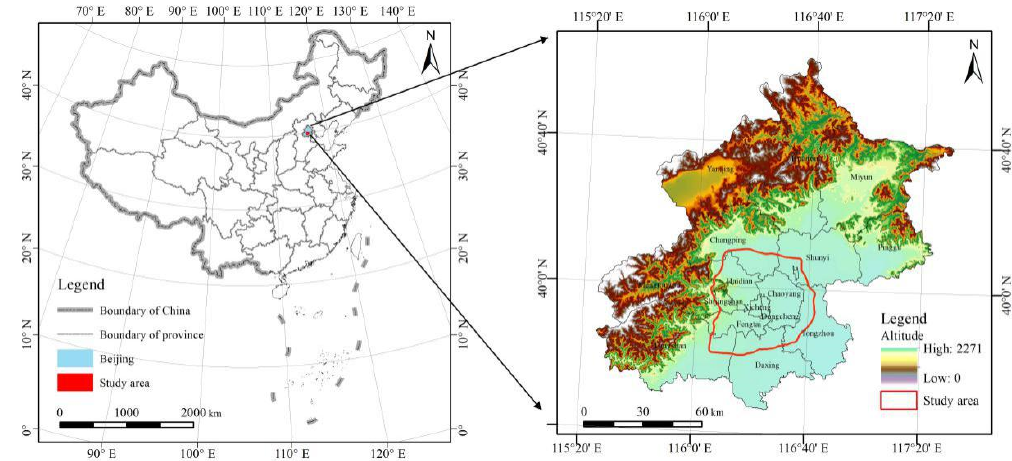
Figure 1. Study area.